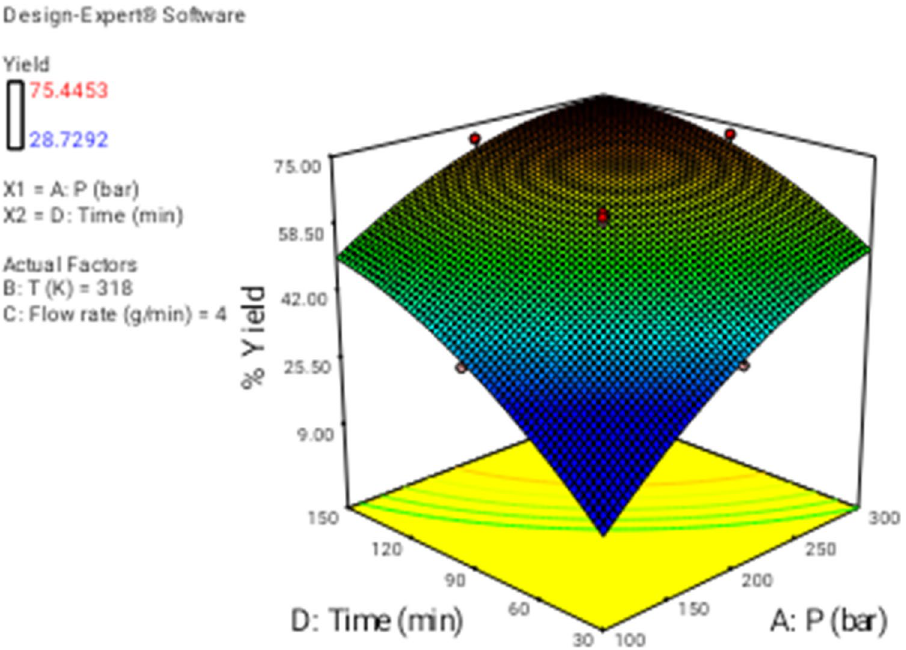
Figure 7. 3D graphic surface for the effects of pressure and time on the